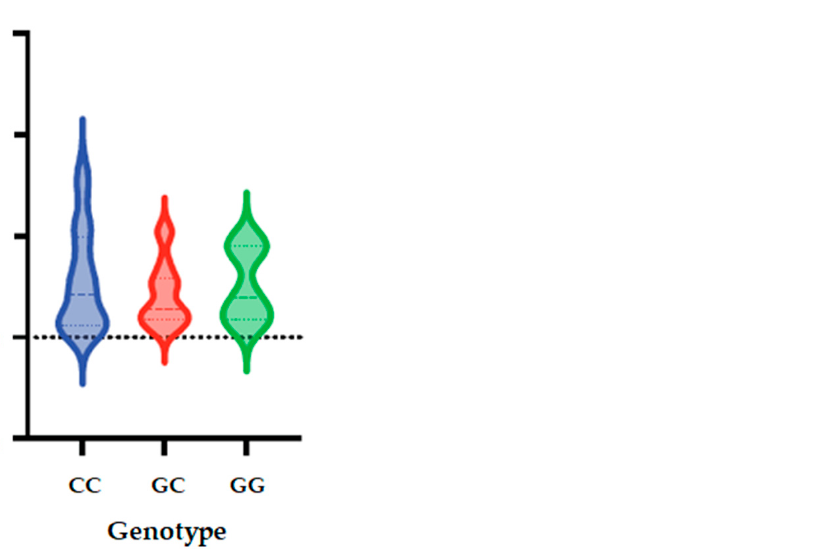
Table 11. Haplotype frequencies for SNPs for ABCC2_rs8187710/SULT1A1_rs3760091/SULT1A1_